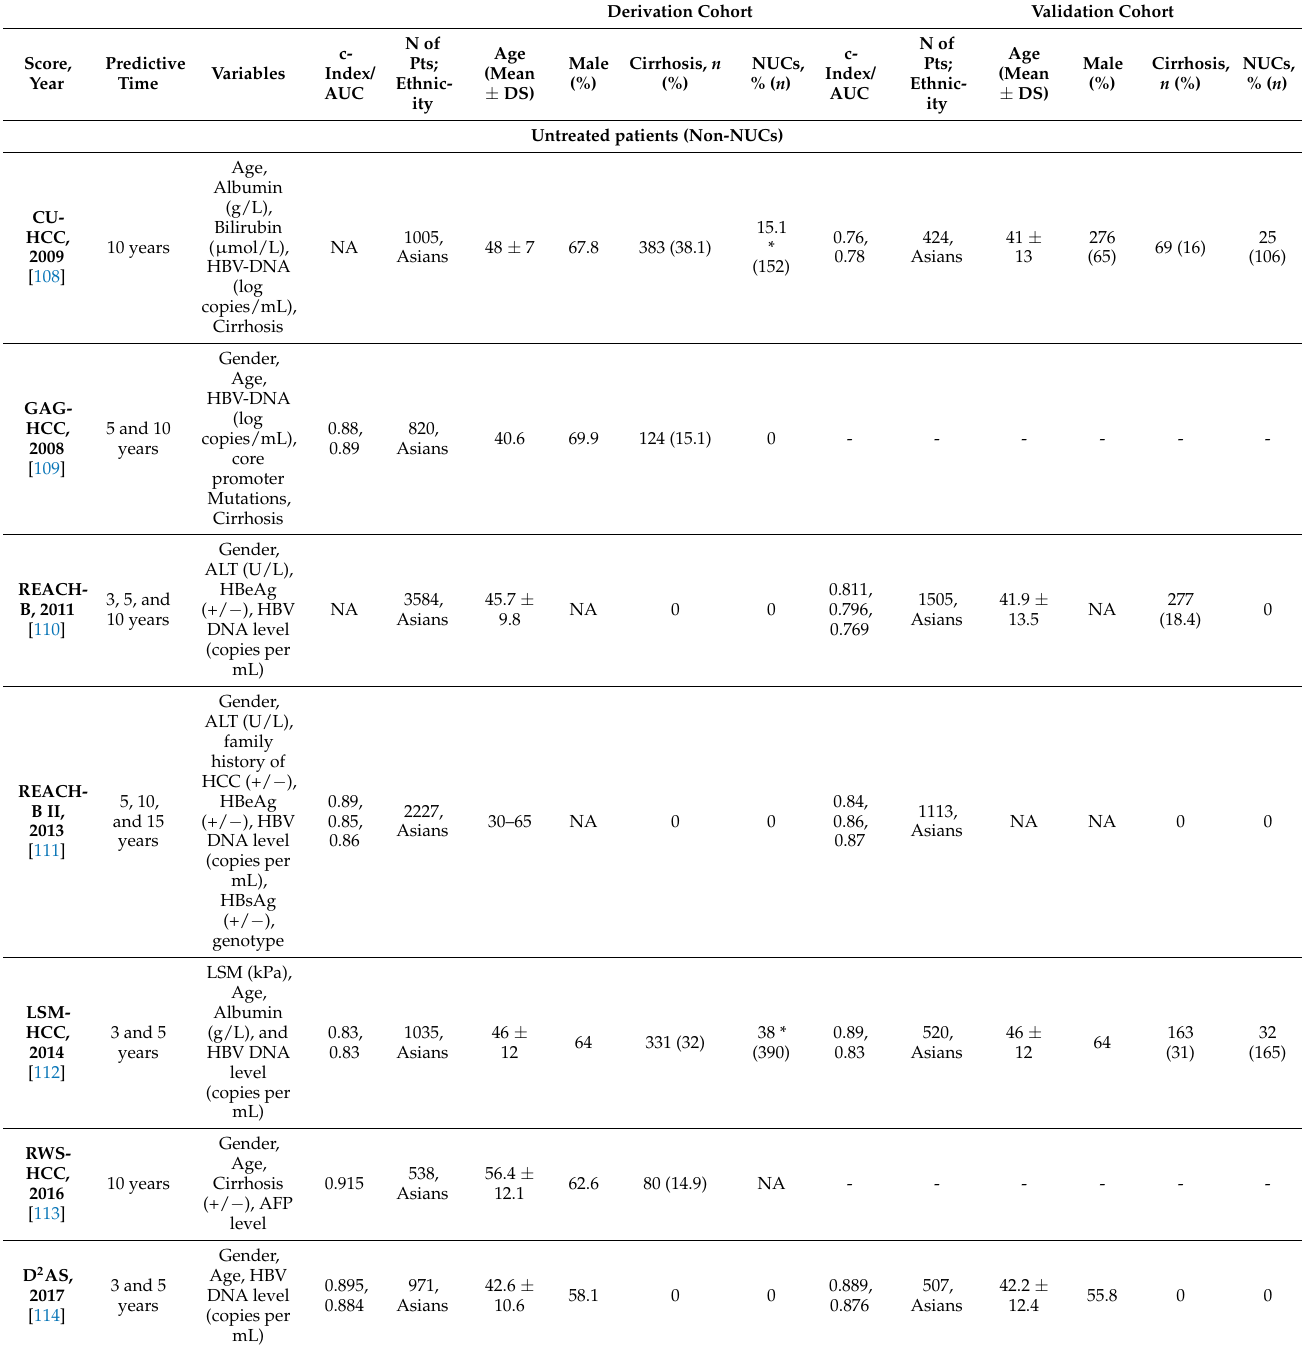
Table 2. Scoring system predictive for hepatocellular carcinoma in HBV